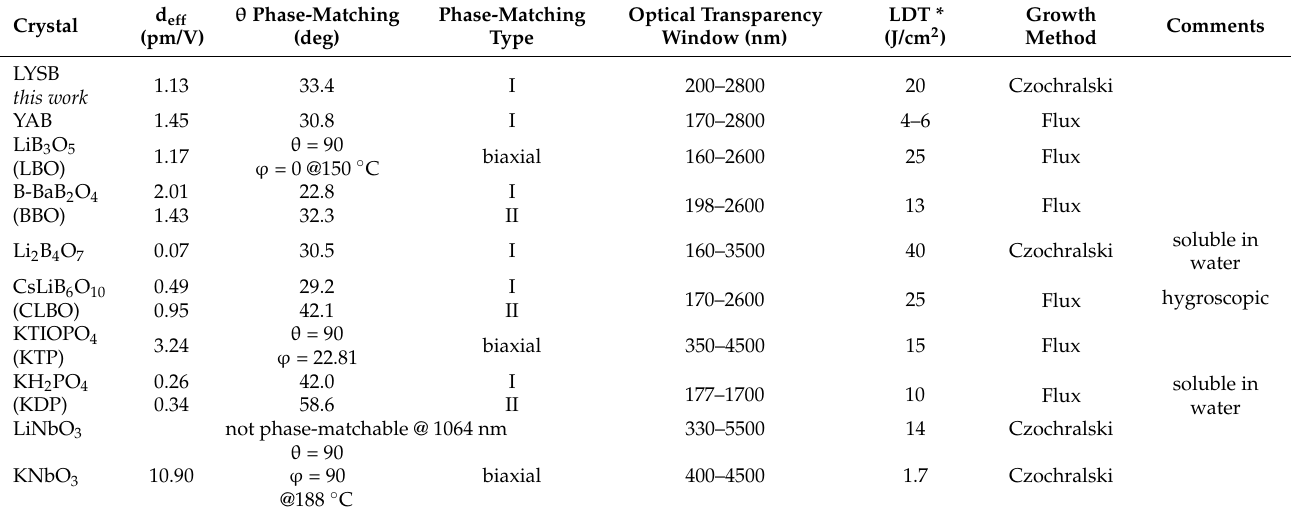
Table 6. NLO properties for SHG of 1064 nm fundamental emission in selected NLO crystals